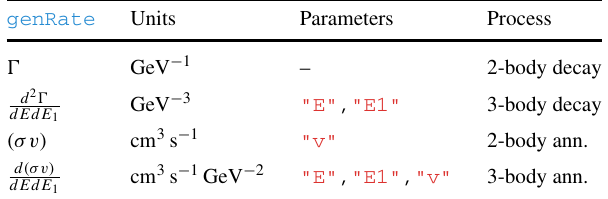
Table 8 Overview of the various definitions of the generalised rate genRate , for different possible processes in the Process Catalog. Note that genRate is a daFunk::Funk object with the indicated param- eters. See main text for